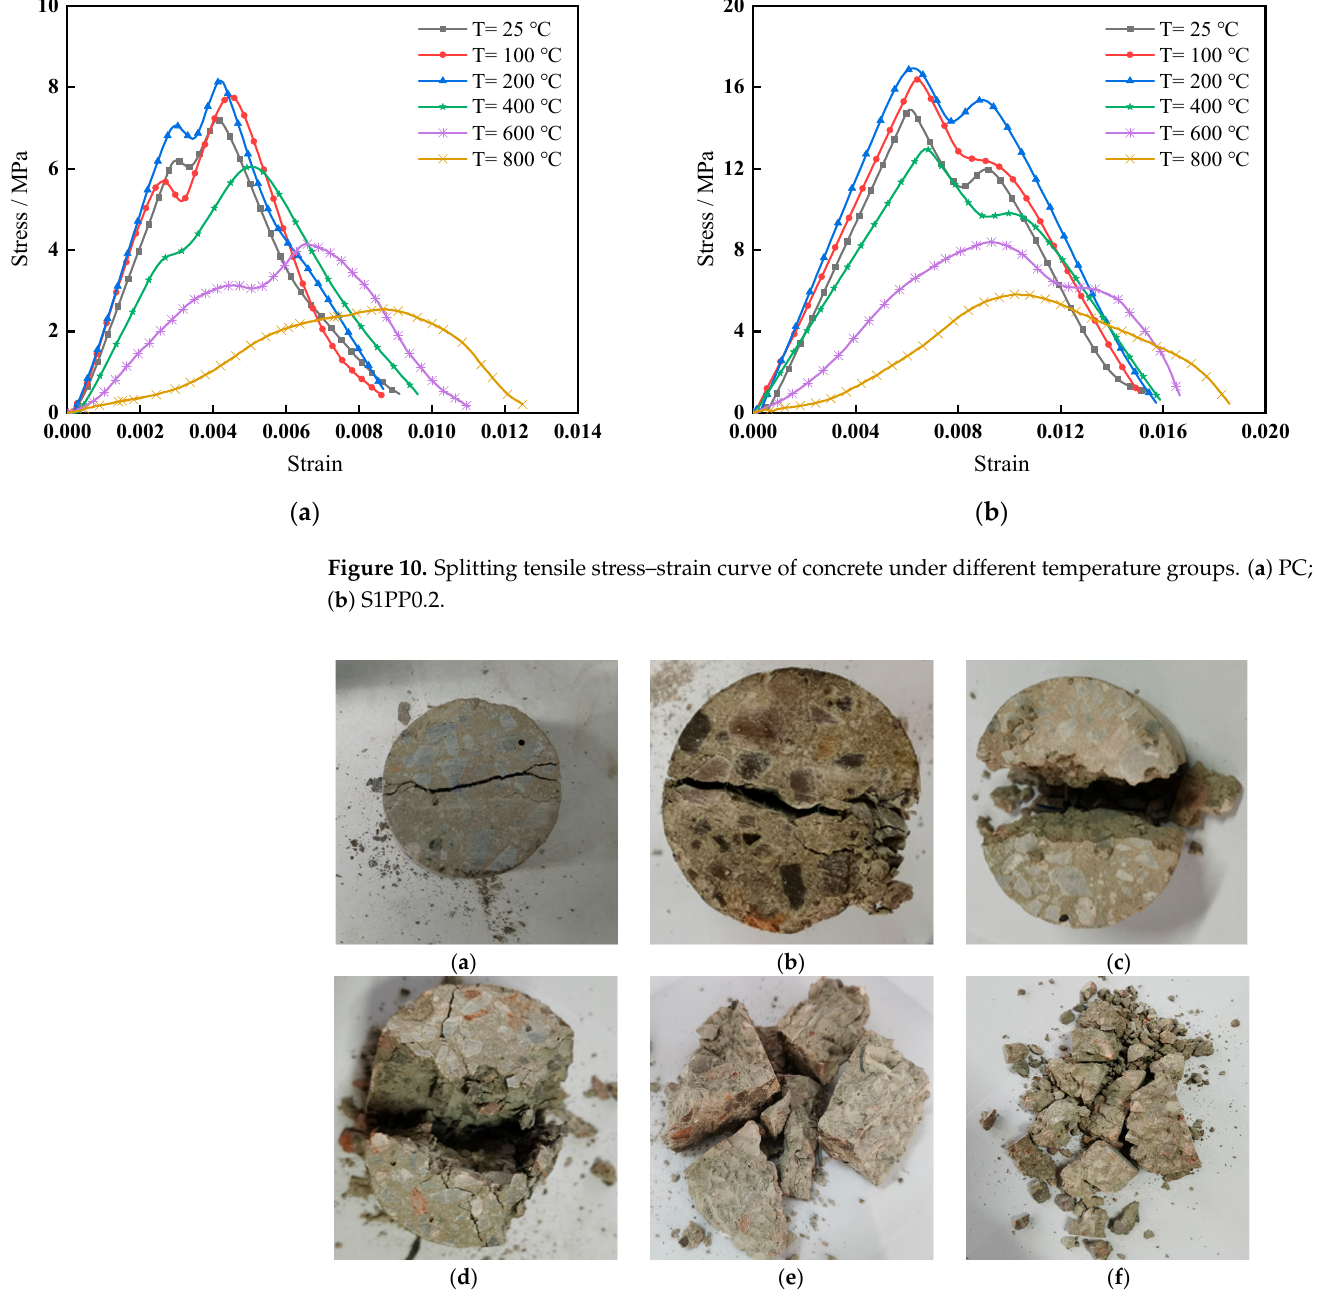
( f ) Figure 12. Failure mode of S1PP0.2 concrete at different temperatures: ( a ) 25 °C; ( b ) 100 °C; ( c ) 200 °C; ( d ) 400 °C; ( e ) 600 °C; ( f ) 800 °C.